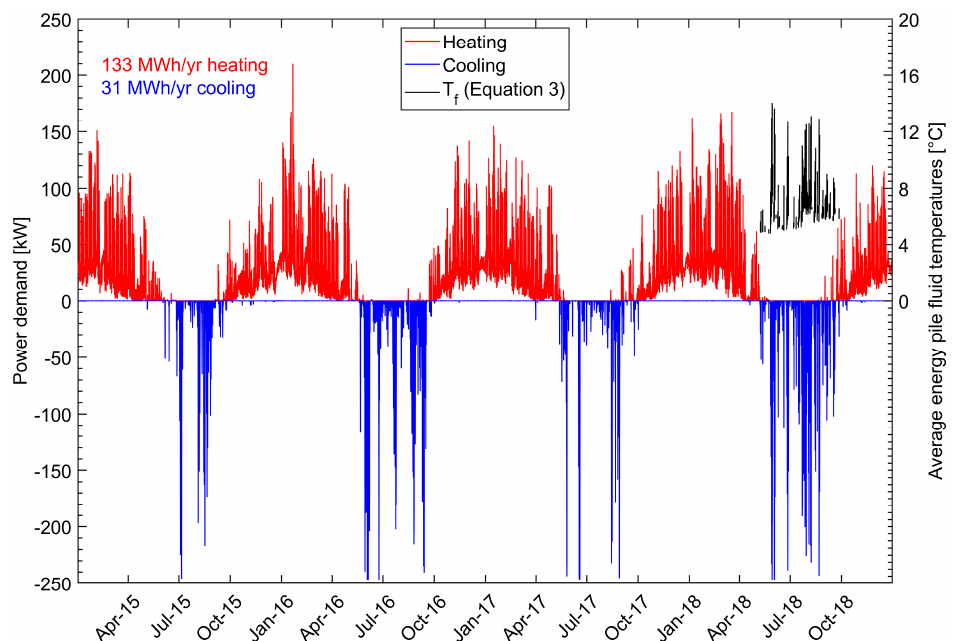
Figure 10. The EnergyPlus estimated heating and cooling demand for Rosborg Gymnasium. Corresponding energy pile fluid temperatures T f are plotted for the cooling season in 2018.